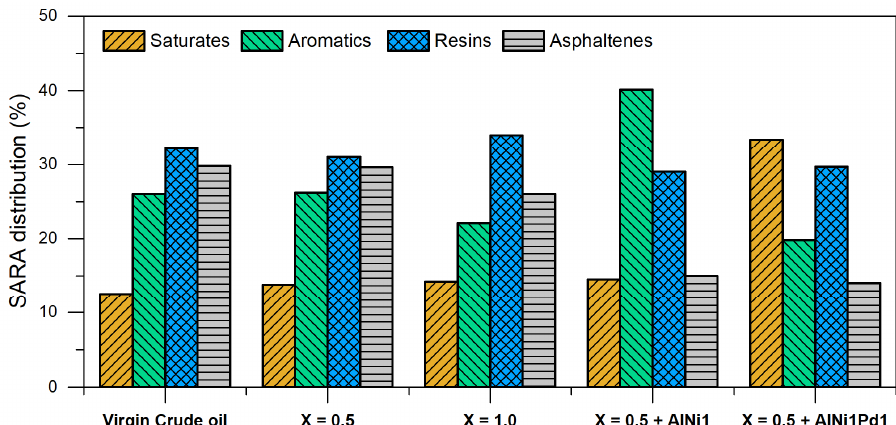
Figure 11. SARA content for untreated extra heavy oil and crude oil recovered after the steam injection at X = 0.5, X = 1.0, and X = 0.5 + AlNi1 and AlNi1Pd1.